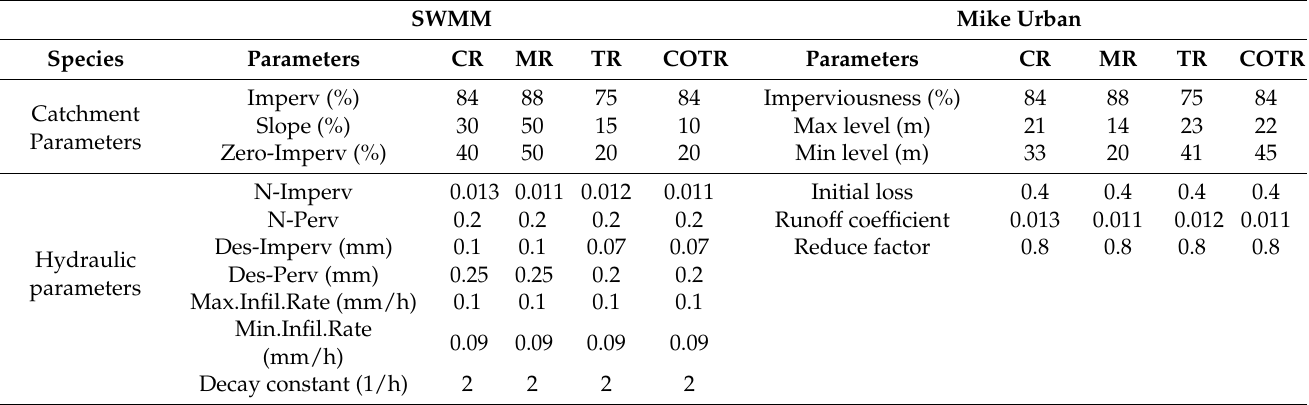
Table 4. SWMM and Mike Urban Model parameters of the four selected flooding point. SWMM Mike